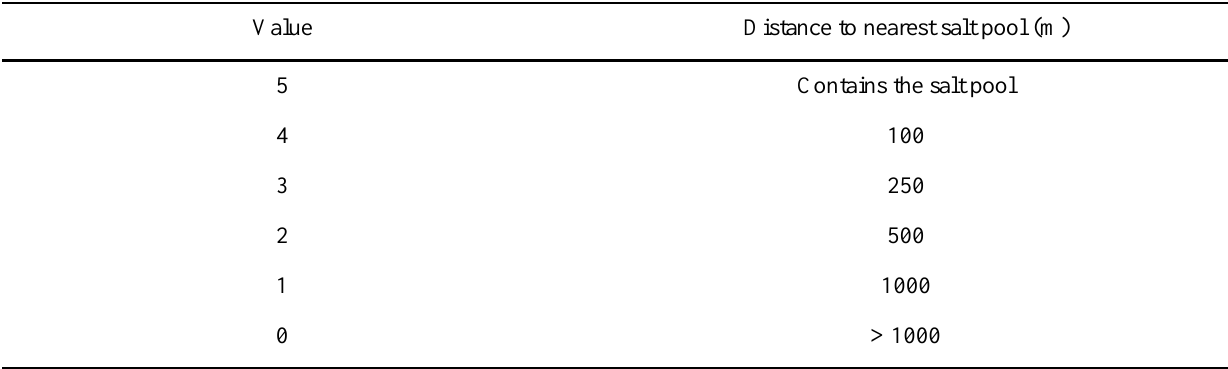
Table 3 . Ranking values used to evaluate the attractiveness of each forest polygon in relation to the distance to the closest salt pool in modeling moose behavior along highways in the Laurentides Wildlife Reserve. Forest polygons that contained a salt pool were assigned a value of 5. Other values were assigned based on their proximity to the nearest salt pools as shown